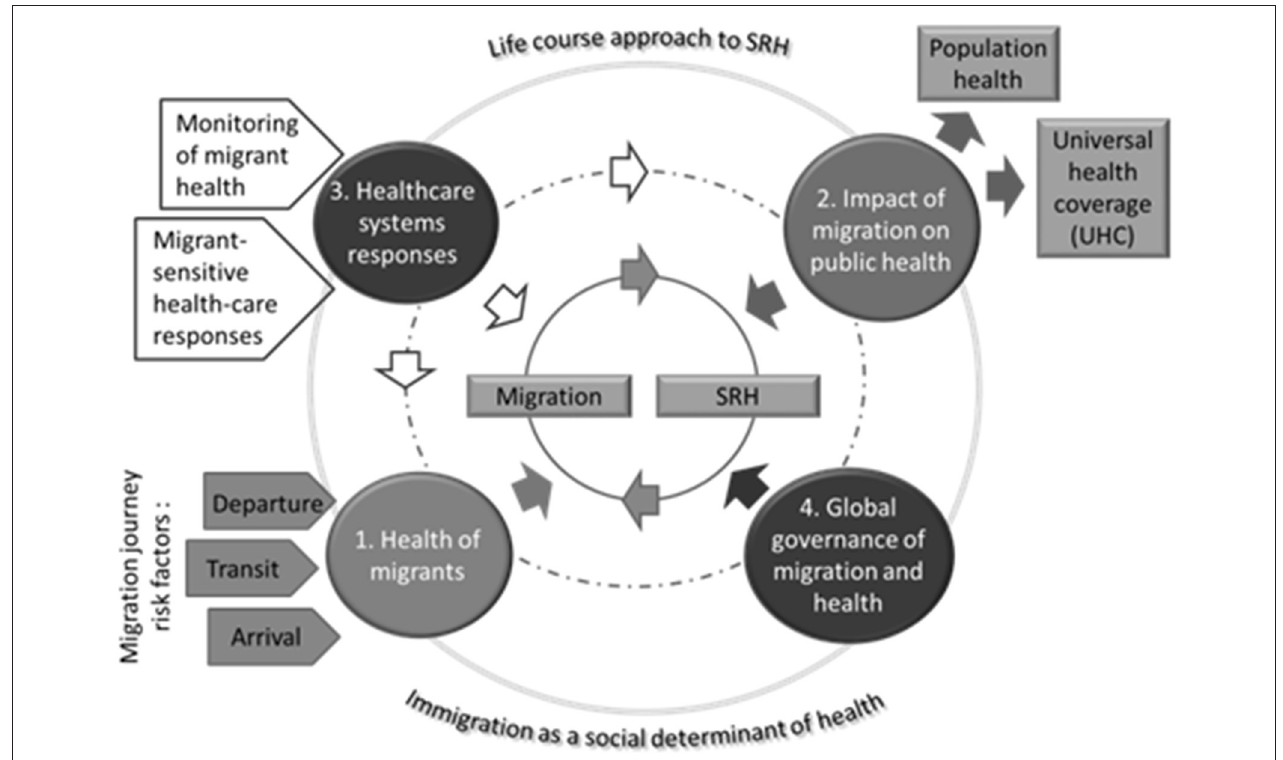
FIGURE 1 | Key aspects and determinants of migration and health. Source: Authors own compilation based on (1,